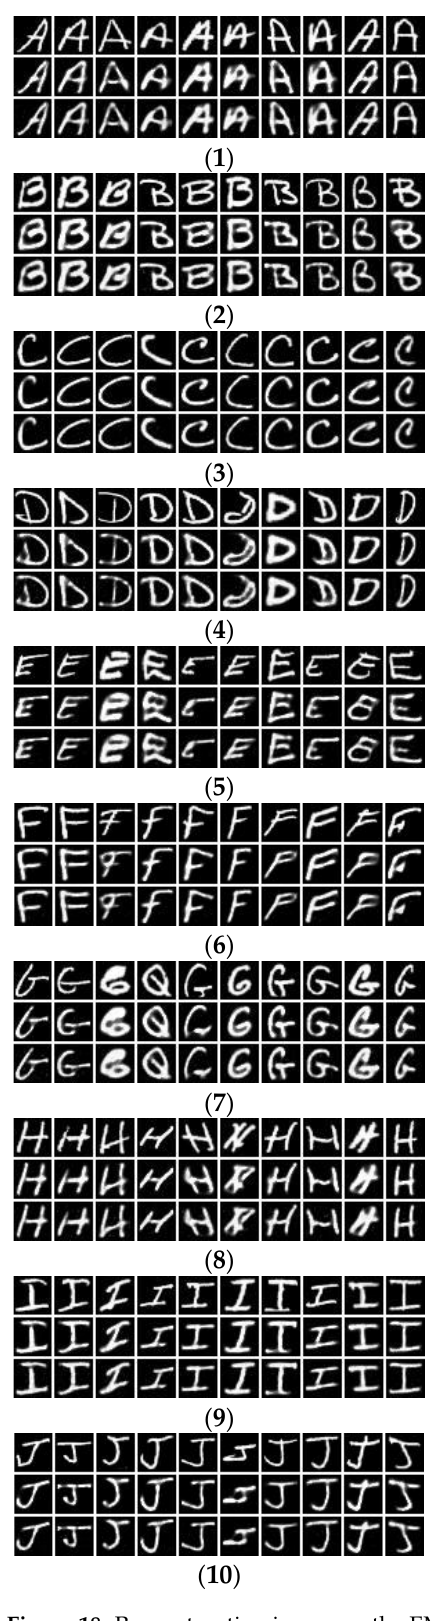
Figure 18. Reconstruction image on the EMNIST data set ( big letters ). For each subfigure, the top row displays the original images, the middle row displays the recovery images of AE, and the bottom row displays the recovery images of RCDAE.